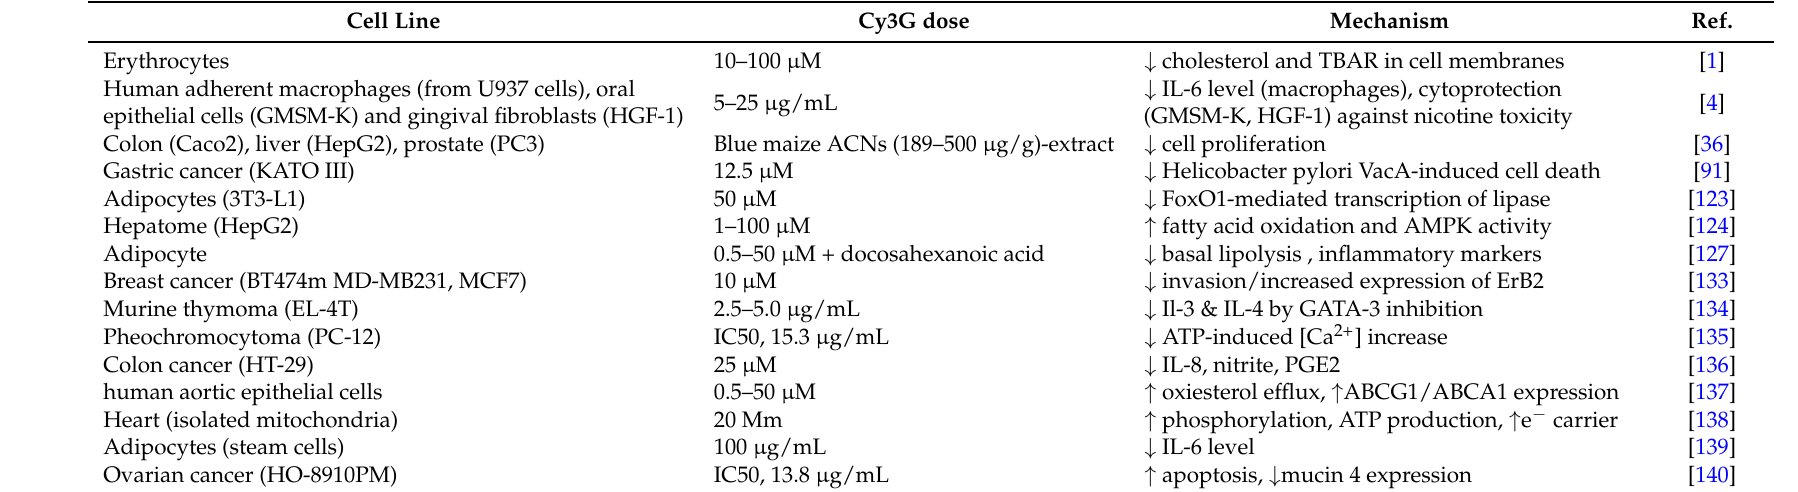
Table 4. Cy3G associated effects-cell lines.